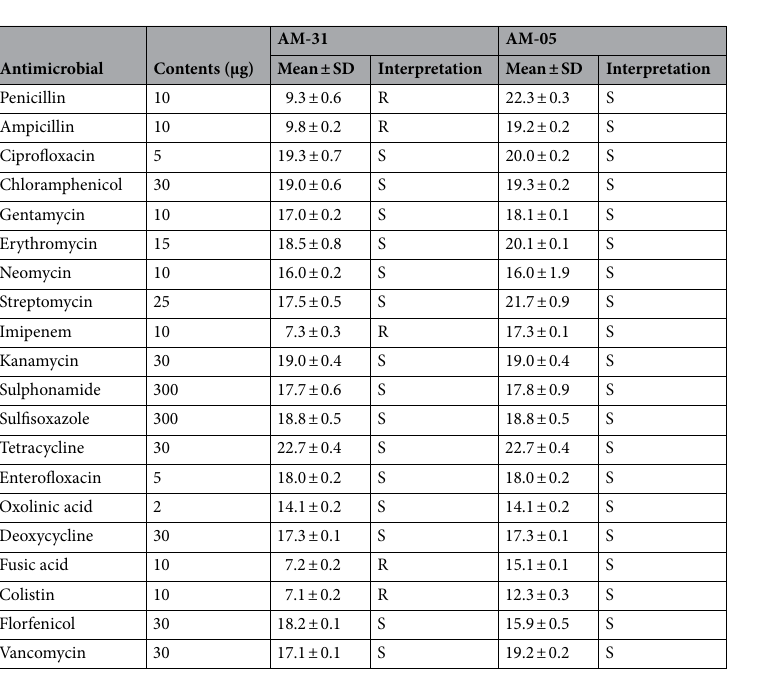
Table 3. Antibiotic susceptibilities interpreted as resistant (R) or sensitive (S) of two bacteria, Aeromonas hydrophila (AM-31) and A. jandaei (AM-05), isolated from naturally-infected Anabas testudineus [Zones of inhibition are expressed as mean (in mm) ± standard deviation